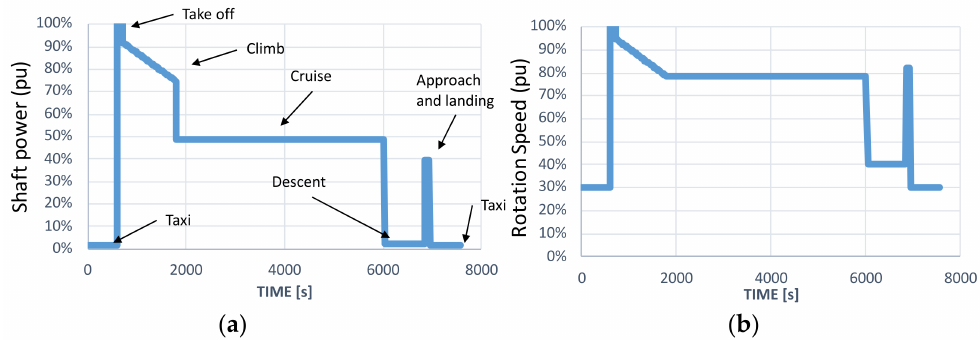
Figure 11. Mission profile during flight phases: ( a ) shaft power, and ( b ) shaft rotational speed.